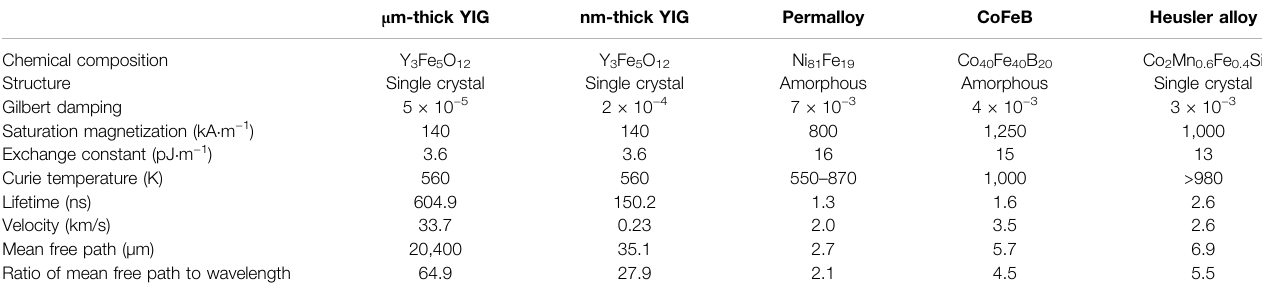
TABLE 1 | Magnetic parameters and spin-wave characteristics of four typical spin-wave materials (Chumak et al., 2017) (licensed under CC BY